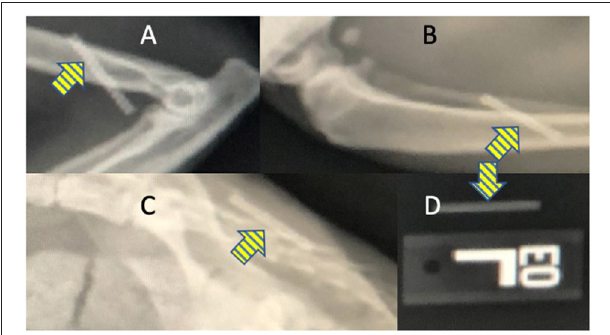
FIGURE 2 | Radiographic images show that the OKV-119 implant is radiopaque (yellow arrows) and can be identified after implantation in cats at the (A) medial brachium, (B) lateral crus, and (C) dorsal lumbar regions. For comparison, the appearance of the OKV-119 implant before implantation is shown in (D) .